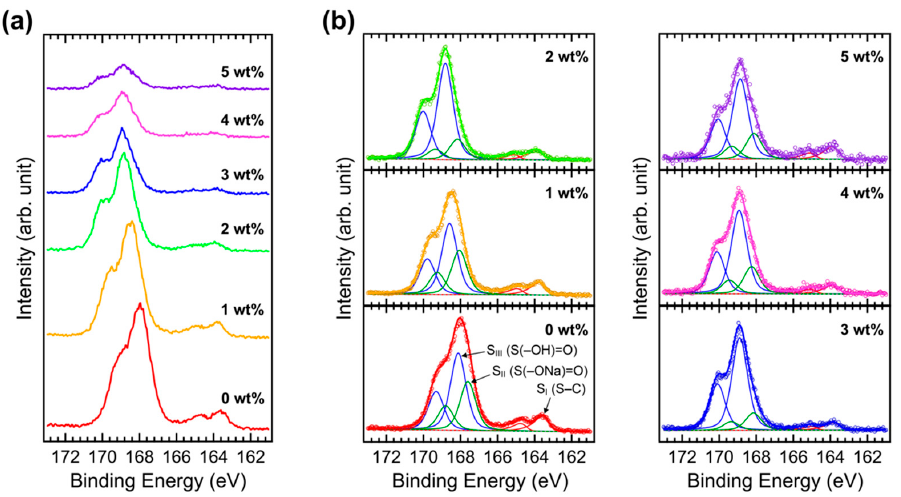
Figure 3. ( a ) XPS S 2p spectra of PEDOT:PSS films on ITO with various concentrations of Brij C10 additive (0, 1, 2, 3, 4, and 5 wt%) and ( b ) their fittings.